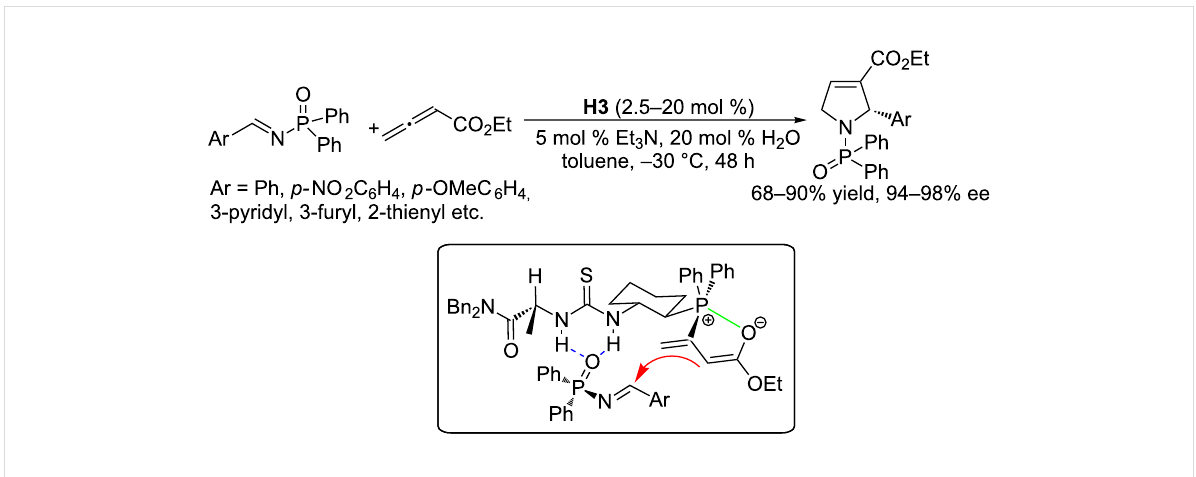
Scheme 33: Asymmetric [3 + 2] annulations of N -diphenylphosphinoyl aromatic imines with allenoates (top), catalyzed by the chiral phosphine H3 , and a possible transition state